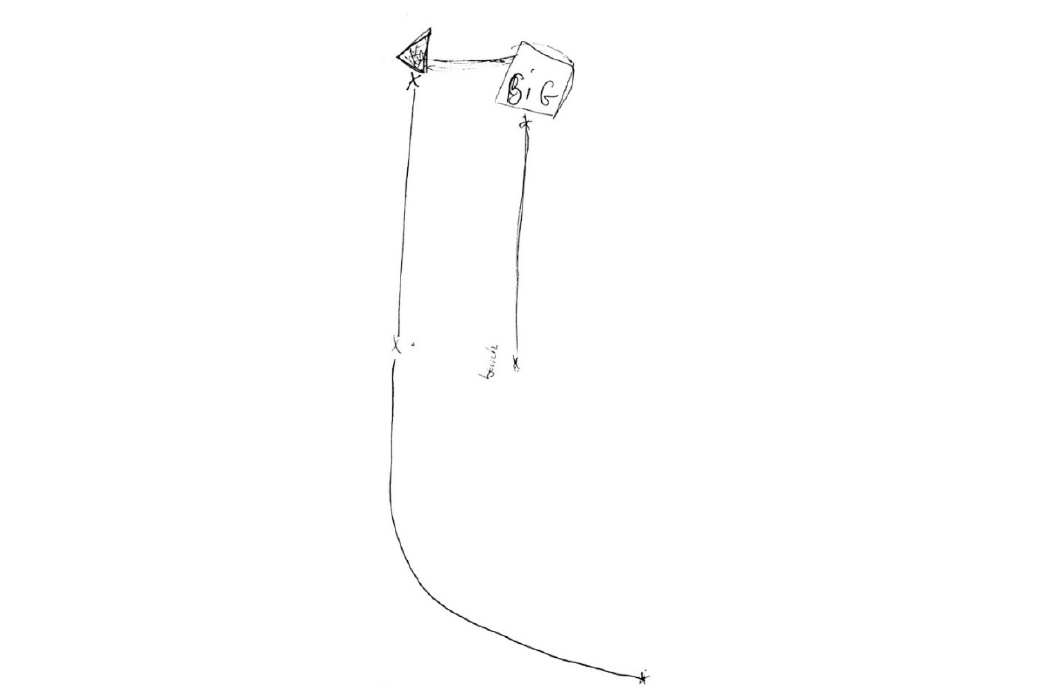
Figure 1: Can you draw the path you took from where you live to here? A mental map taken during an interview done in 2012 Source: Verazzi (2015, p.